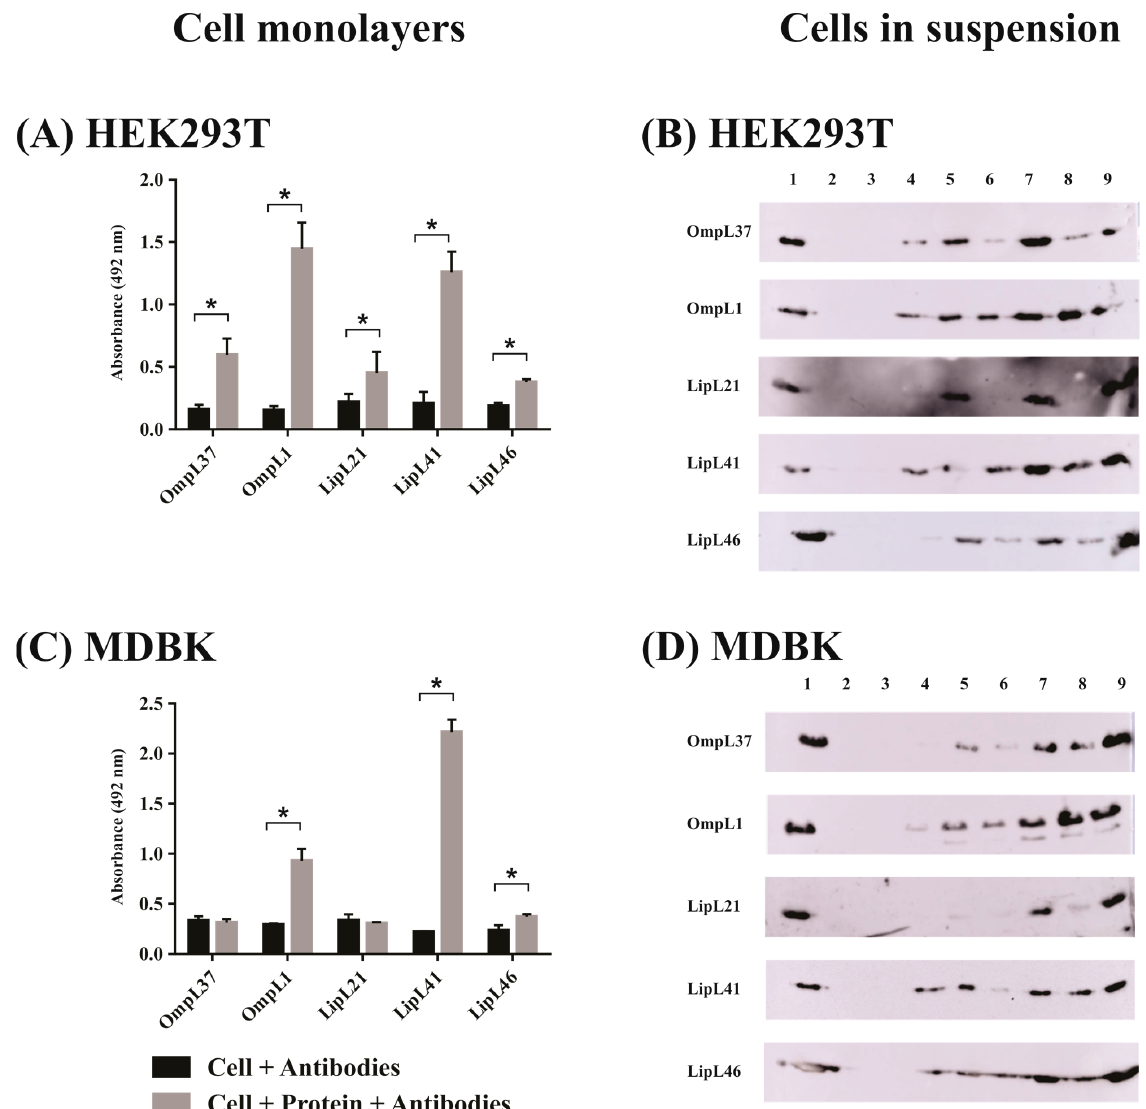
respectively; 6–7: pellet and supernatant with addition of 5 µg of protein, respectively; and 8–9: pellet and supernatant with addition of 10 µg of protein, respectively.